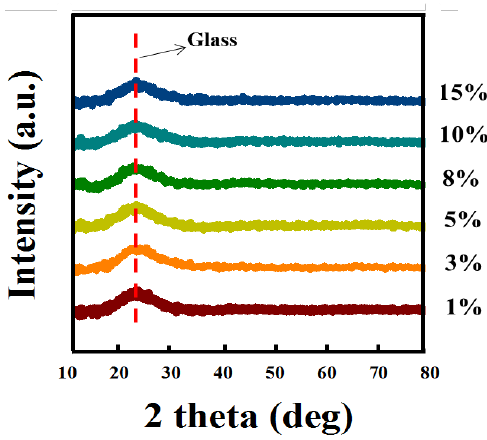
Figure 2. XRD spectra of the IGTO films deposited at a substrate temperature of 350 °C by spray pyrolysis, where Ga concentration varied from 1 to 20%. The peak at 25° is related to glass. The optical bandgaps of IGTO films (Ga: 1 to 10%) are shown in Figure 3a. For UV- Vis measurement, the a-IGTO films were deposited on the glass (Corning eagle), where the glass absorption can be negligible [2,22 – 24]. The increase in bandgap with an increase in Ga ratio in IGTO from 3.62 (1% Ga) to 3.69 eV(10% Ga). The bandgap of IGTO is higher than that of ITO (3.19 eV) due to a higher bandgap of GaO (4.8 eV) [3,6,10]. The optical bandgap, E g , was extracted using the relationship: αhν = A (hν − E g ) 1/n , where α, hν, A, and n are the absorption coefficient, photon energy, a proportionality constant, and opti- cal transition exponent in the absorption process, respectively. XPS valance band spectra of IGTO ((Ga: 0 to 15%)) films measured are shown in Figure 3b. The Fermi energy level (E F ) shifts from 2.44 (1% Ga) to 2.27 eV (15% Ga) above the valence band edge, as shown in Figure 3b. To achieve the accurate Fermi-level position, the Ultra-violet photoelectron spectroscopic (UPS) experiment was conducted for the IGTO thin films with different Ga fractions. The work function ( ) values for IGTO films with the different (1, 10, and 15%) Ga ratios are 4.49, 4.56, and 4.59 eV, respectively. With increasing Ga incorporation Fermi level shifts away from the conduction band (CB) as shown in Figure 3c. This indicates the